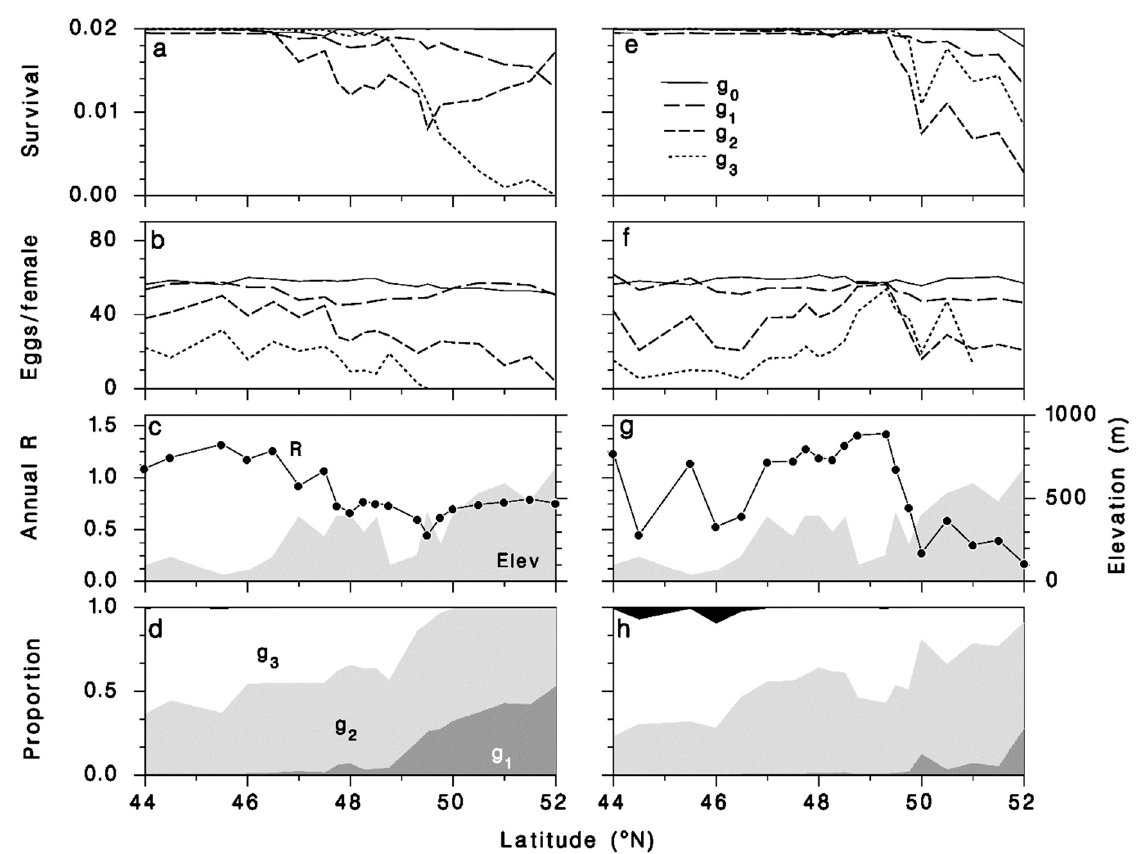
Figure 9. Model output along the latitudinal transect (diamonds in Figure 2) using weather from periods 1991–2020 ( a – d ) and 2021–2050 ( e – h ). ( a , e ) Actia interrupta survival from maggot to adult, including 97.96% culling in each generation. ( b , f ) Realized fecundity. ( c , g ) Annual population growth rate (overwintering maggots) and elevation ( gray shade ). ( d , h ) Contribution (proportion) of each generation of adults to the overwintering population. Initial generation (g 0 : solid ), subsequent generations (g 1 : long dash , g 2 : short dash , g 3 : dotted ).